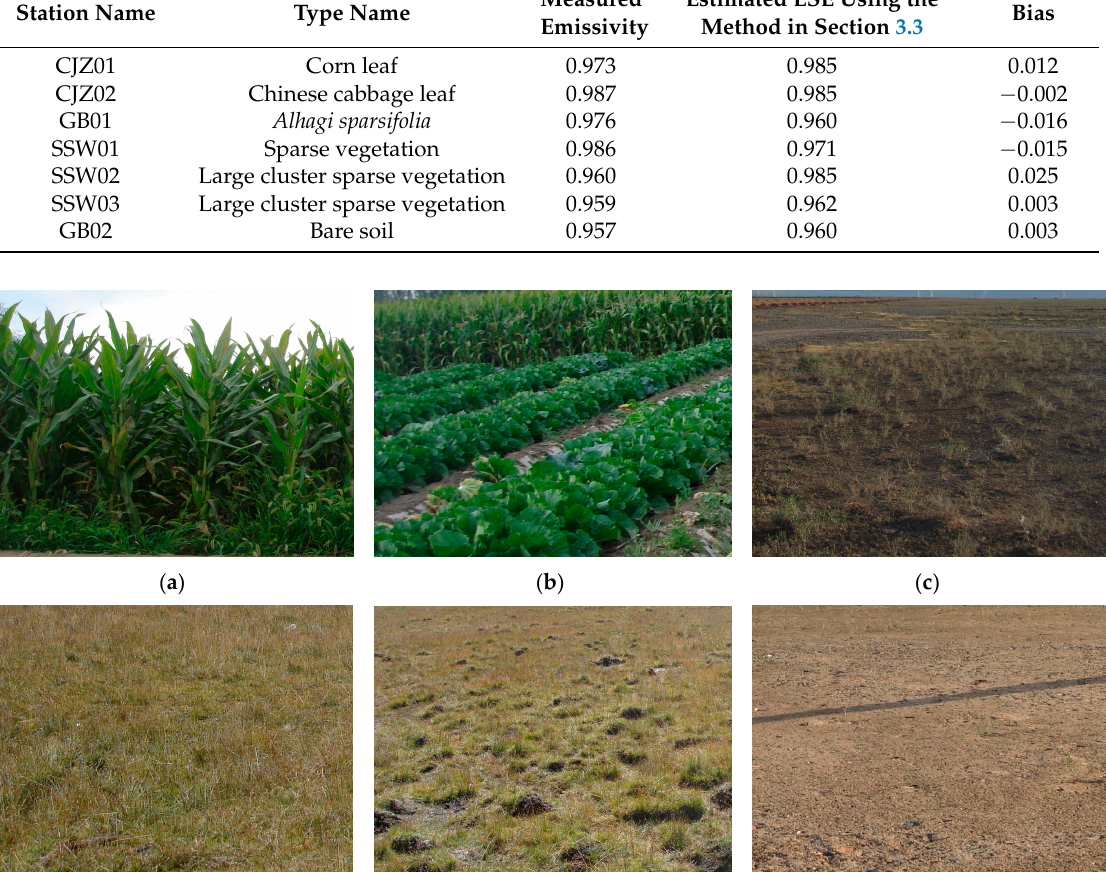
Table 3. List of measured emissivities, estimated LSEs and the bias between them for different types.